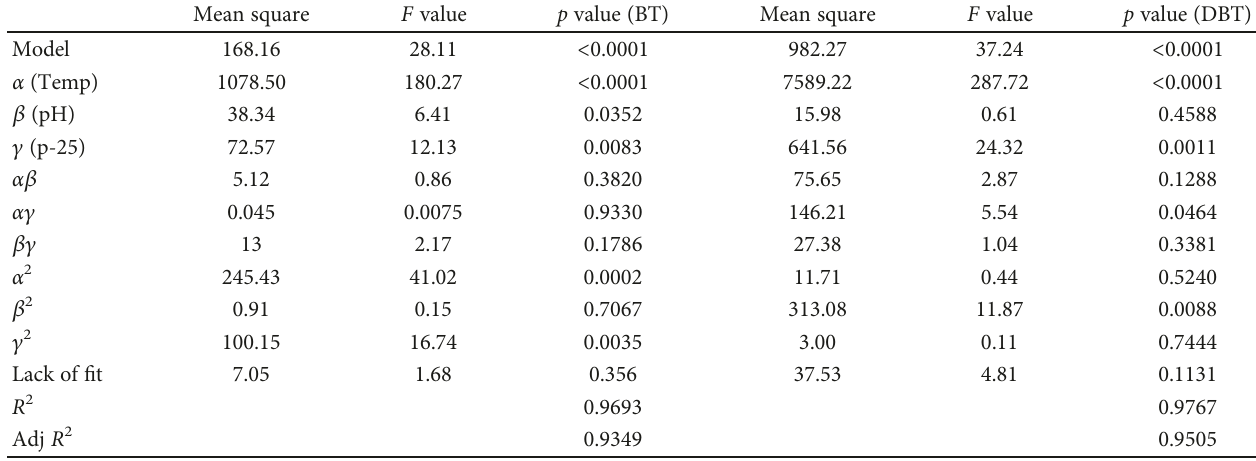
Table 4: ANOVA results for quadratic model of BT and DBT photooxidation.